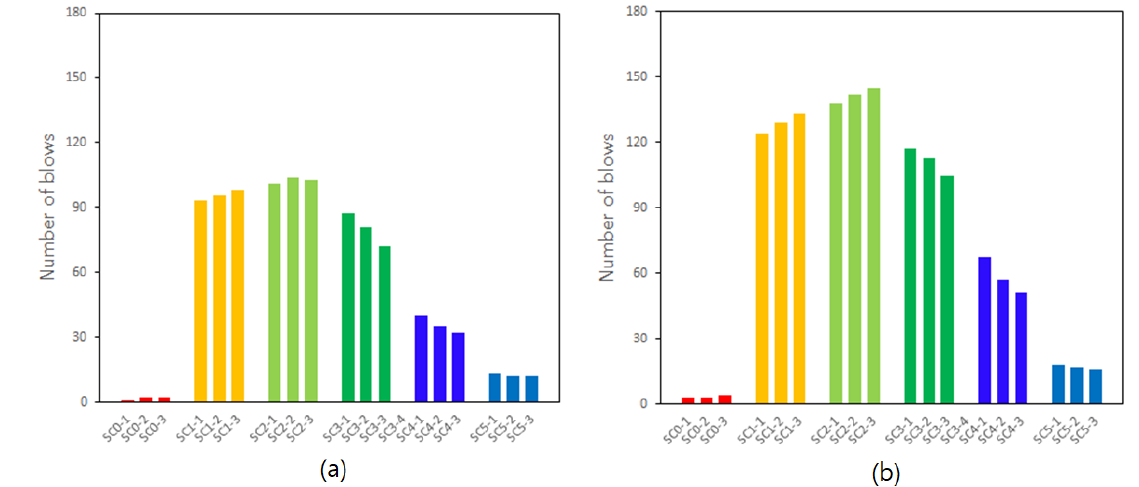
Figure 10. Number of blows for specimens; ( a ) first crack, and ( b ) final failure.